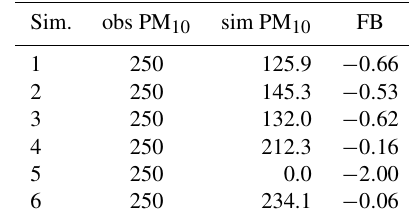
Table 3. Average mass density of PM 10 deduced from the measure- ments in Boulevard Alsace Lorraine (obs PM 10 ; mgm − 2 ), average simulated mass density of PM 10 (sim PM 10 ; mgm − 2 ), and the frac- tional bias (FB;